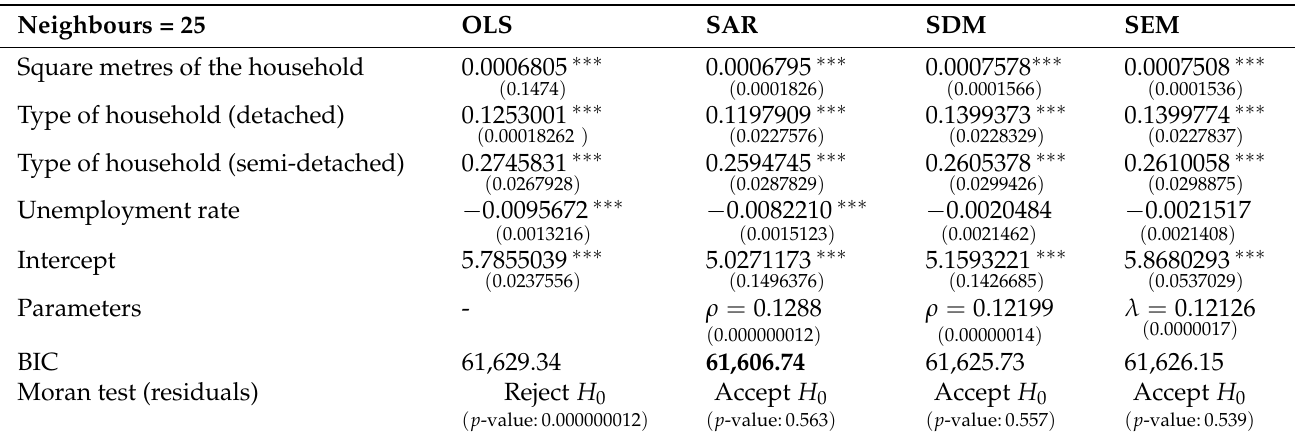
Table 4. General results.